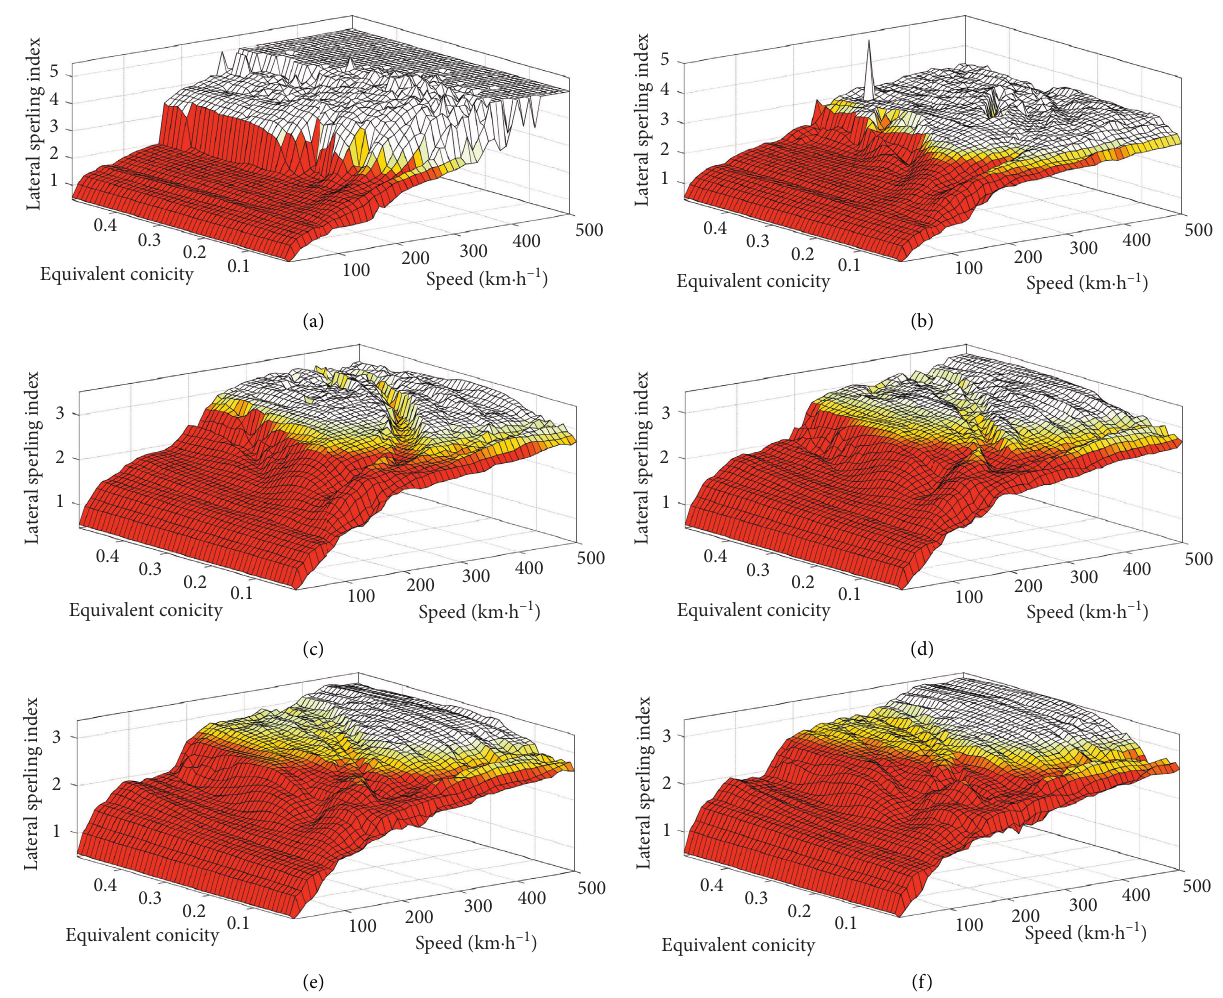
Figure 12: Vehicle ride quality space with joint stiffness of 70 MN · m − 1 and additional stiffness of 0. (a) c � 0. (b) c � 110kN · s · m − 1